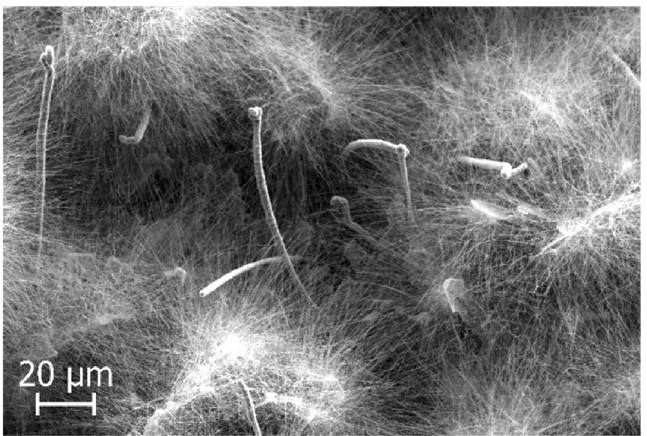
Figure 13. The SiC structure formed in the white region of the crucible at 1650 °C using 5% CH 4 in H 2 as the process gas.